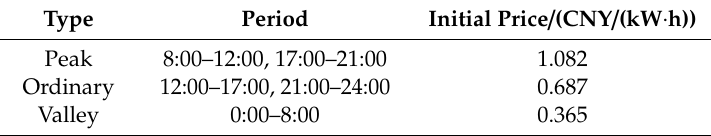
Table 2. Electricity price without bidding of EVs.